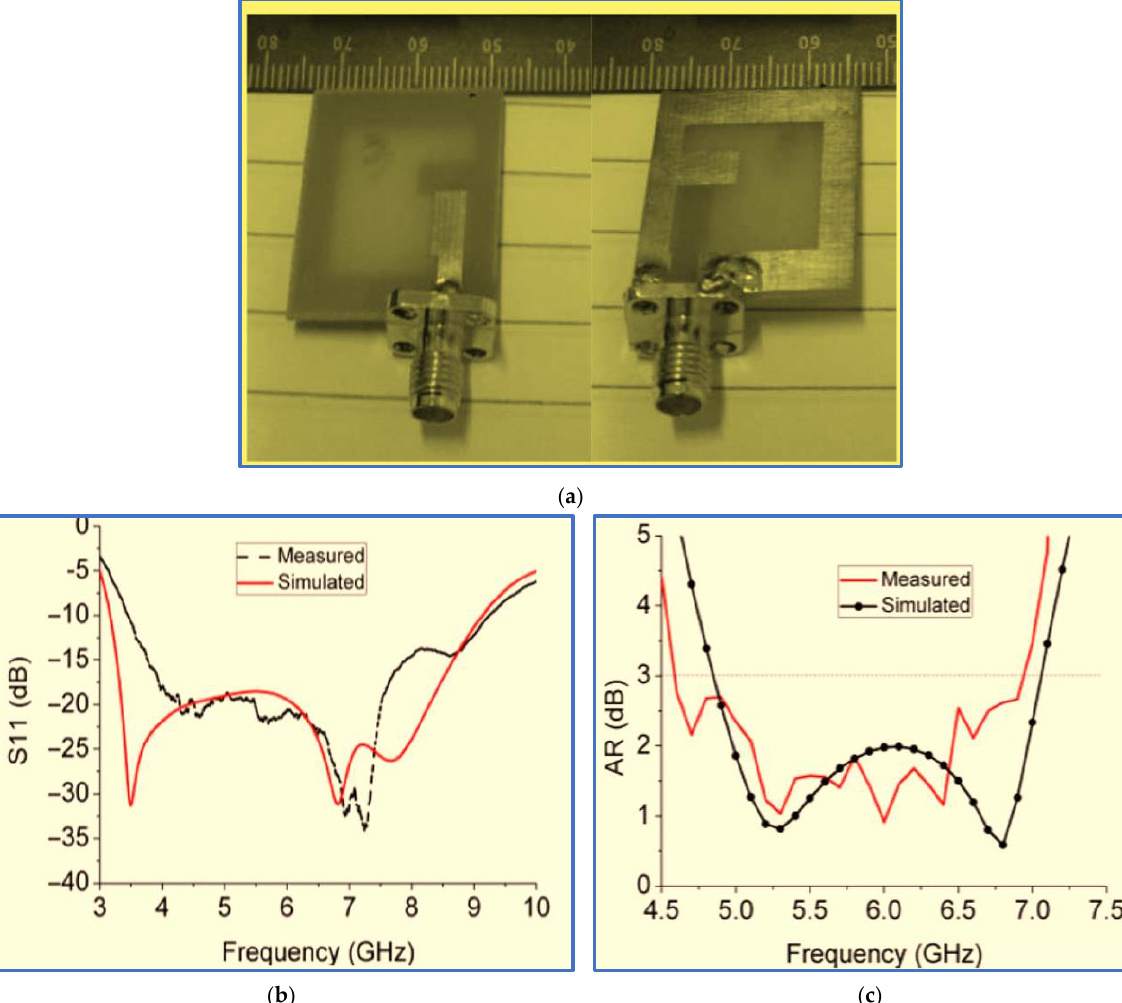
Figure 10. ( a ) Front and back views of a wide rectangular slot antenna. ( b ) Simulated and measured S11 results and ( c ) simulated and measured AR [87].